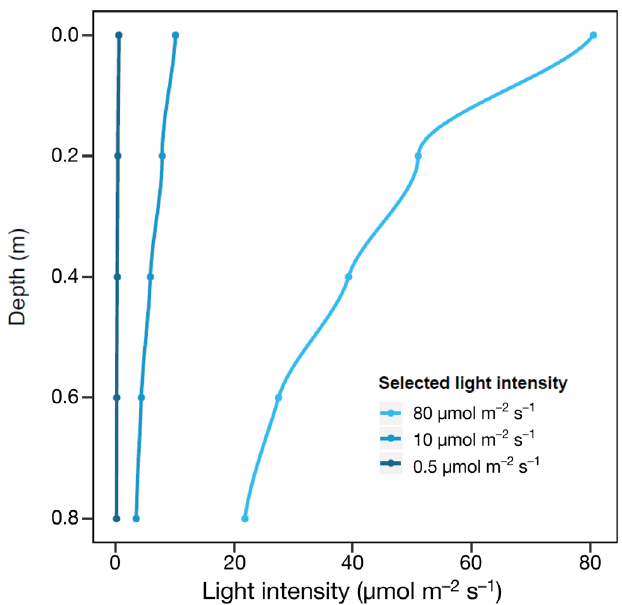
intensitiesFig. 2. Light attenuation curve for experimental light intensi- ties. Measurements were taken at every 20 cm in the